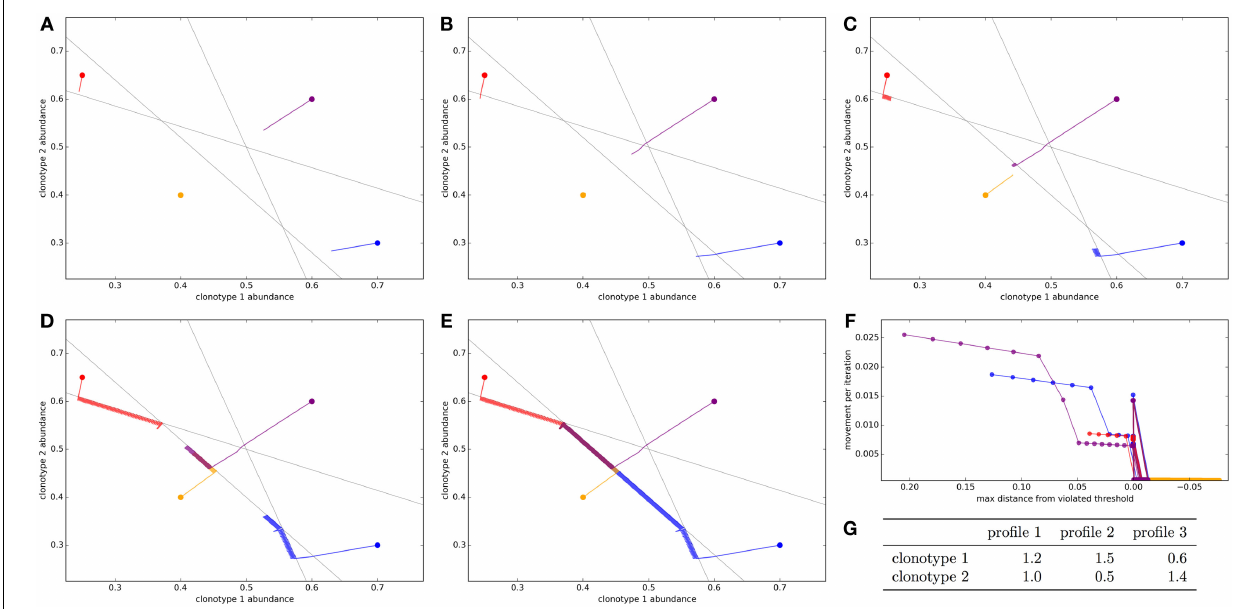
FIGURE 1 | Optimization of the T cell population to avoid autoimmunity while maximizing T cell numbers in a simplified system with two clonotypes and three spMHC profiles . The update algorithm is initiated with different initial clonotype abundances each represented by a different color. The colored lines track the changes in clonotype abundance over iterations of the update algorithm (A–E) . The clone abundances after (A) 5, (B) 10, (C) 100, (D) 1,000, or (E) 10,000 iterations of the update algorithm. The gray lines indicate the constraint that total T cell response should be less than the